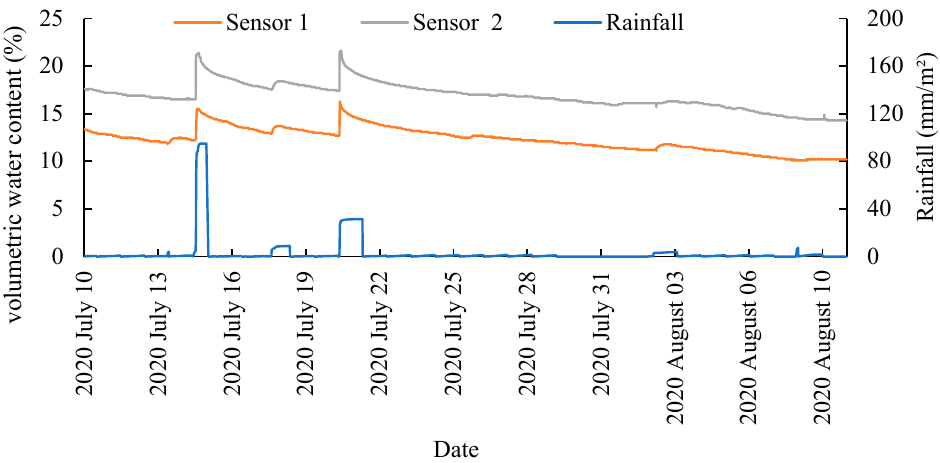
Figure 13. Field measurement results.